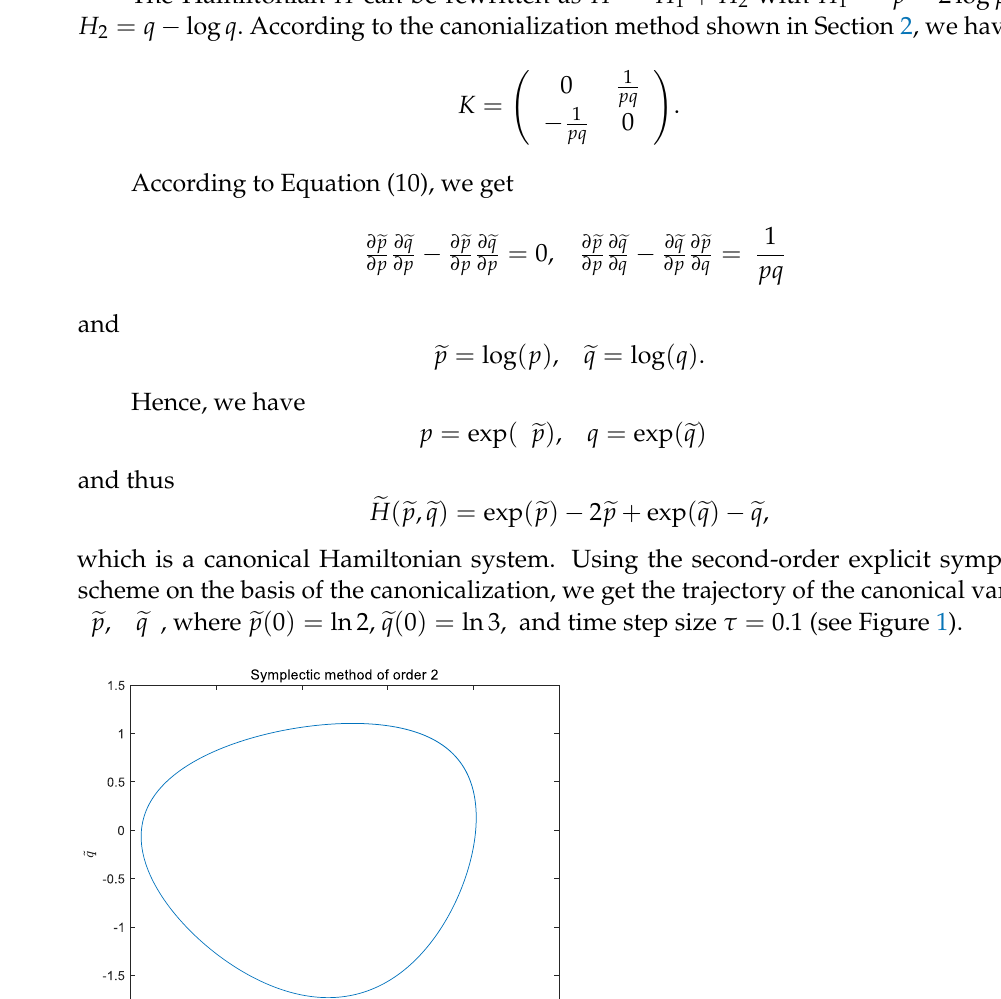
Figure 1. Trajectory of the canonical variable qp